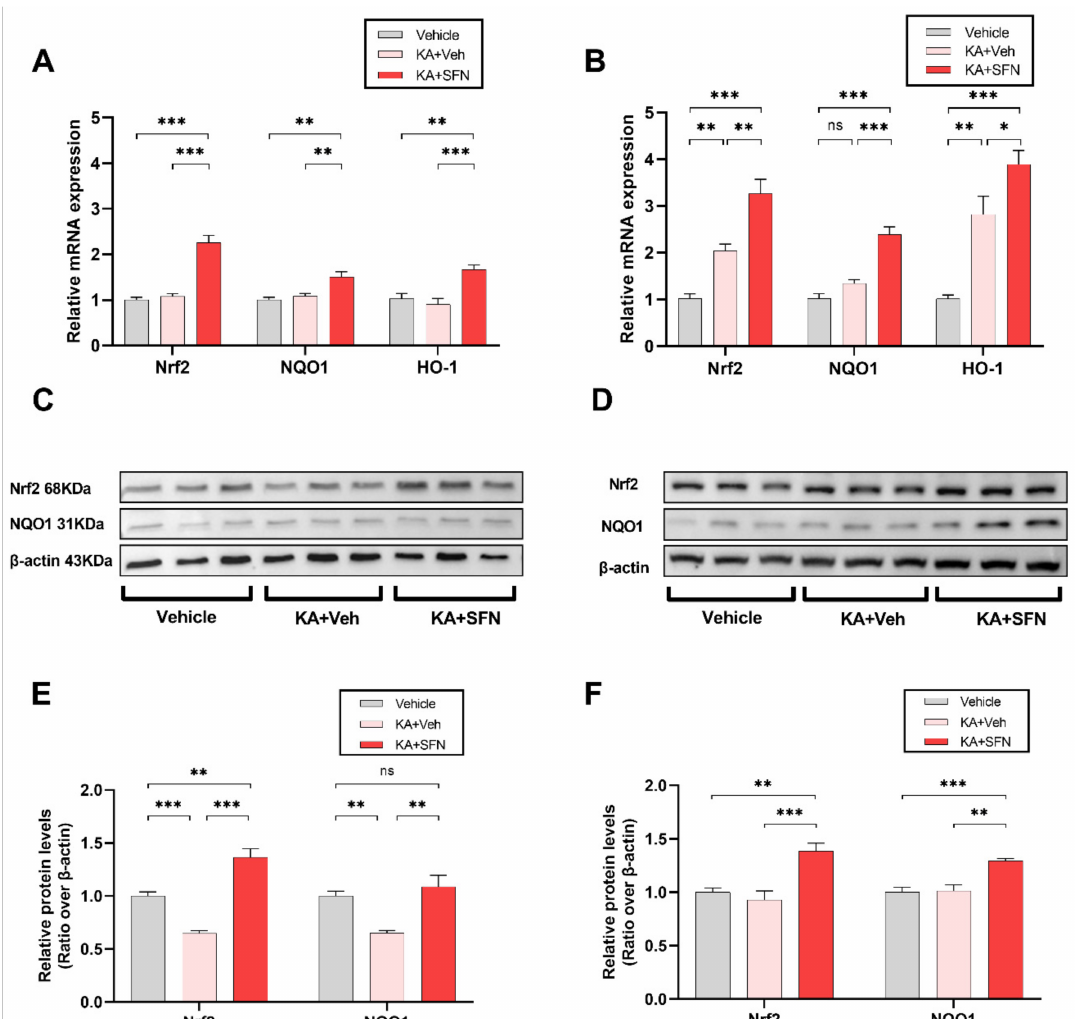
Figure 2. SFN increases the expression of Nrf2, NQO1 and HO1 following in vivo SE. Expression of Nrf2, NQO1, and HO1 mRNAs in cortex ( A ) and hippocampus ( B ), 7 days following vehicle treatment (no KA-SE, n = 6) and rats subjected to 2 h of KA-SE and treated either with SFN (5 mg/kg once a day for 5 days, first dose within 10 min following SE, n = 6) or vehicle (equivalent volume and number of injections, n = 6). ( C , D ). Representative immunoblots of Nrf2, NQO1, and of same animals as in ( A ) and ( B ) as detected by western blotting. E-F. Relative expression (over β -actin) of Nrf2 and NQO1 total proteins in cortex ( E ) and hippocampus ( F ) of blots in ( C , D ), respectively. Data are displayed as the mean ± SEM, * p < 0.05, ** p < 0.01, *** p < 0.001 analysed by one-way ANOVA followed by Tukey’s multiple comparisons